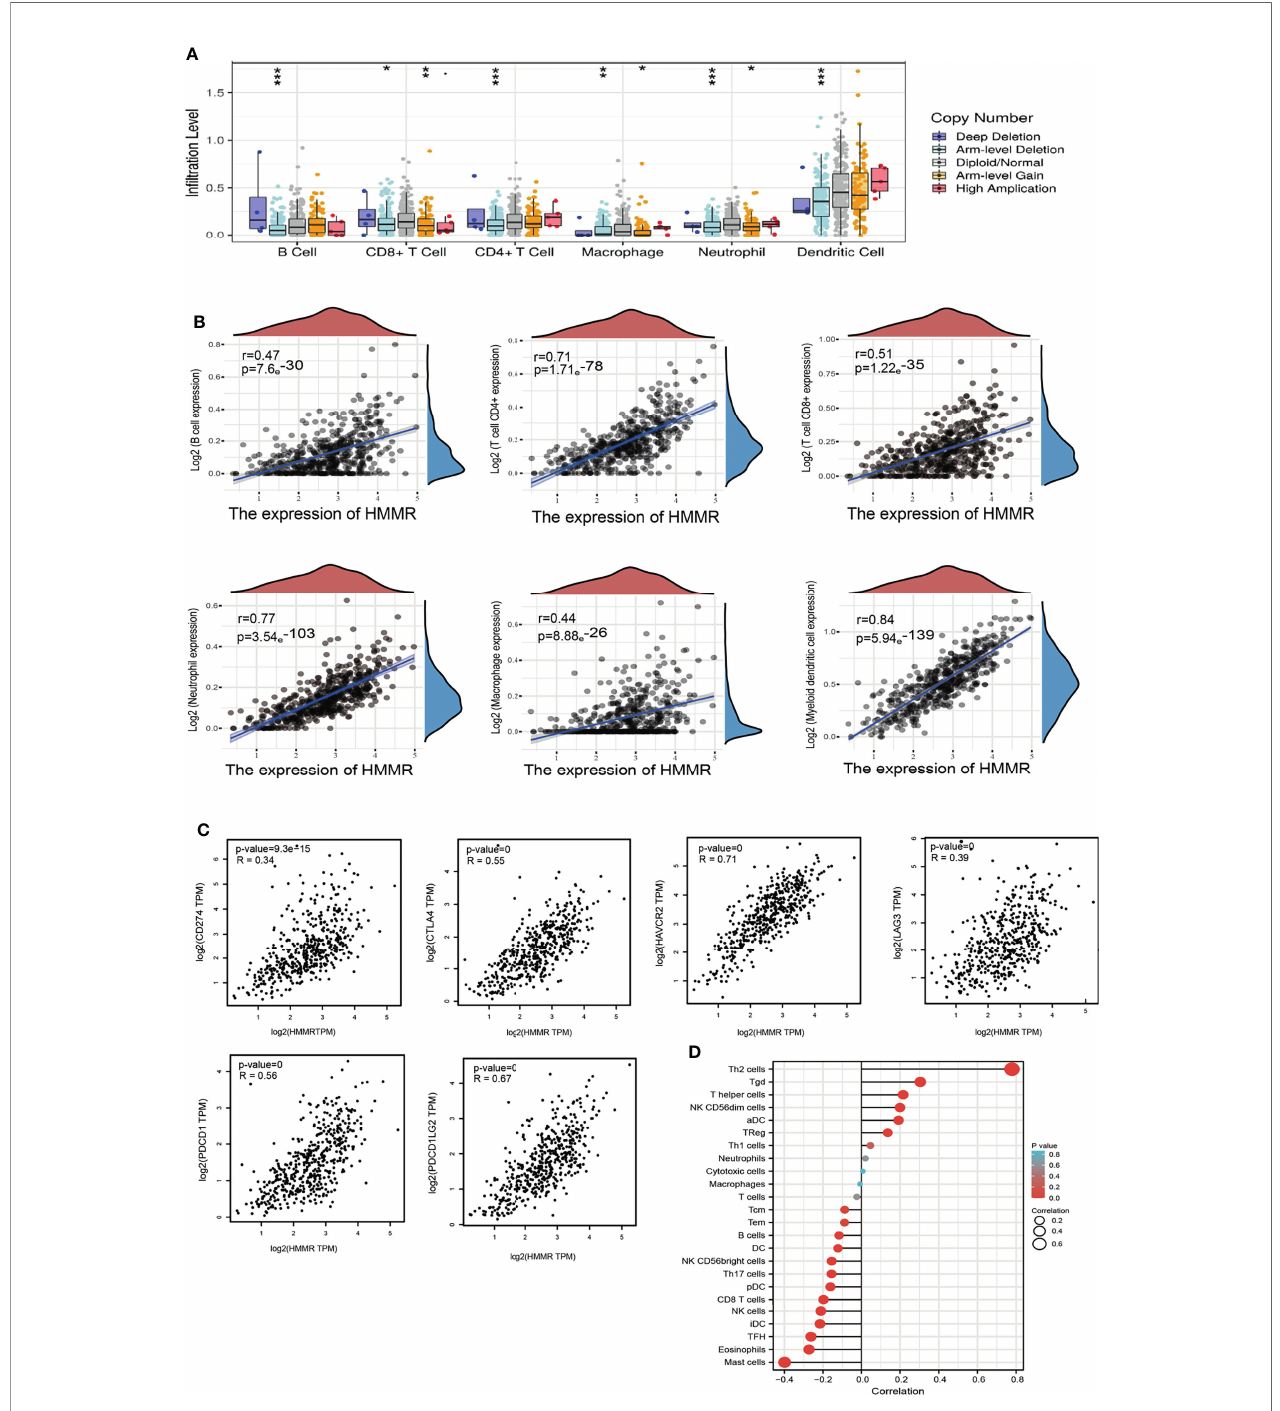
FIGURE 6 | HMMR expression was associated with immune in fi ltration in LUAD. (A) The correlation between HMMR CNV and immune cells in LUAD examined by TIMER database. (B) The correlation between HMMR expression and immune in fi ltration in LUAD examined by TIMER database. (C) The correlation between HMMR expression and immune checkpoints related gene expression in LUAD. (D) The correlation between HMMR expression level and 24 immune cell types. *P < 0.05; **P < 0.01; *** <